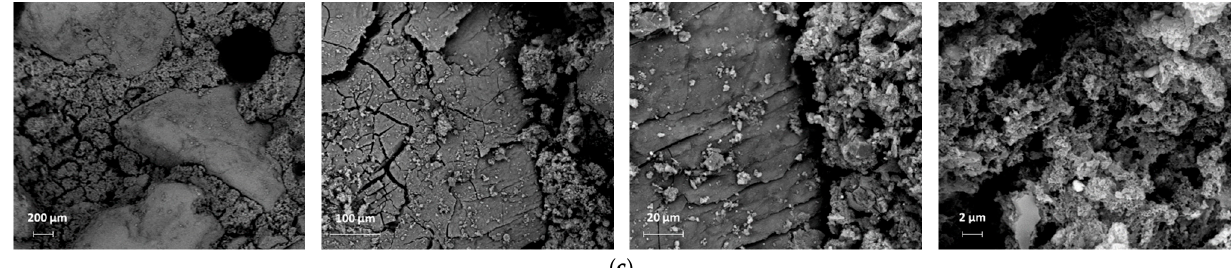
Figure 22. SEM images of mortars after 7 days of acid exposure: Ctrl ( a ), RGE5 ( b ), and RGE50 ( c ).